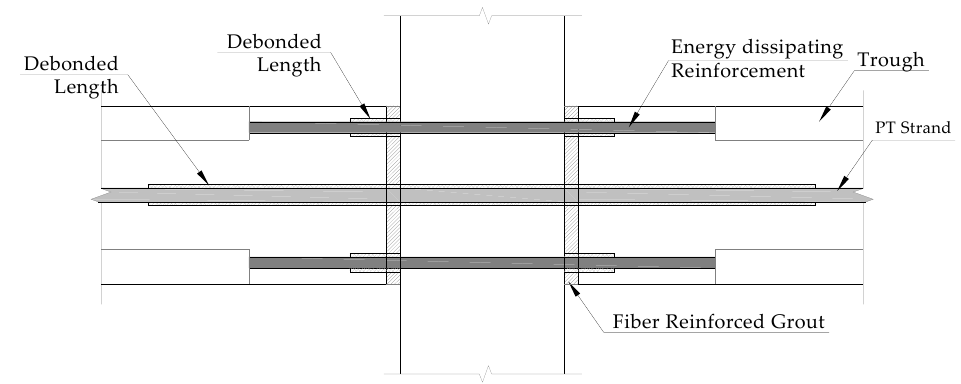
Figure 7. Undeformed hybrid connection [27].